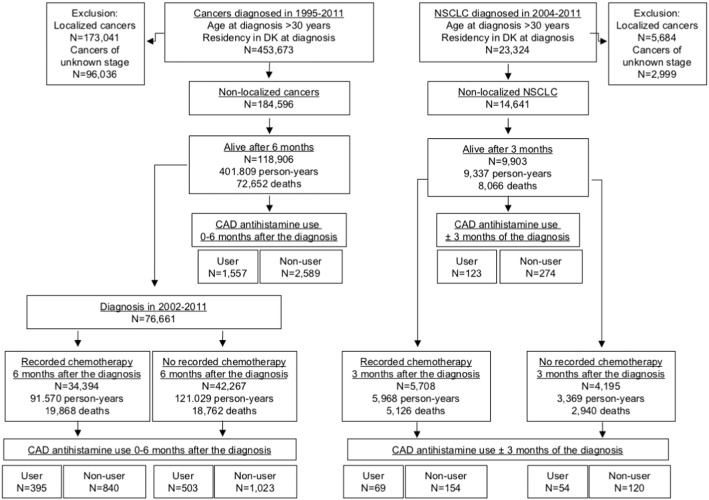
Consort flow diagram of the cohort studies.